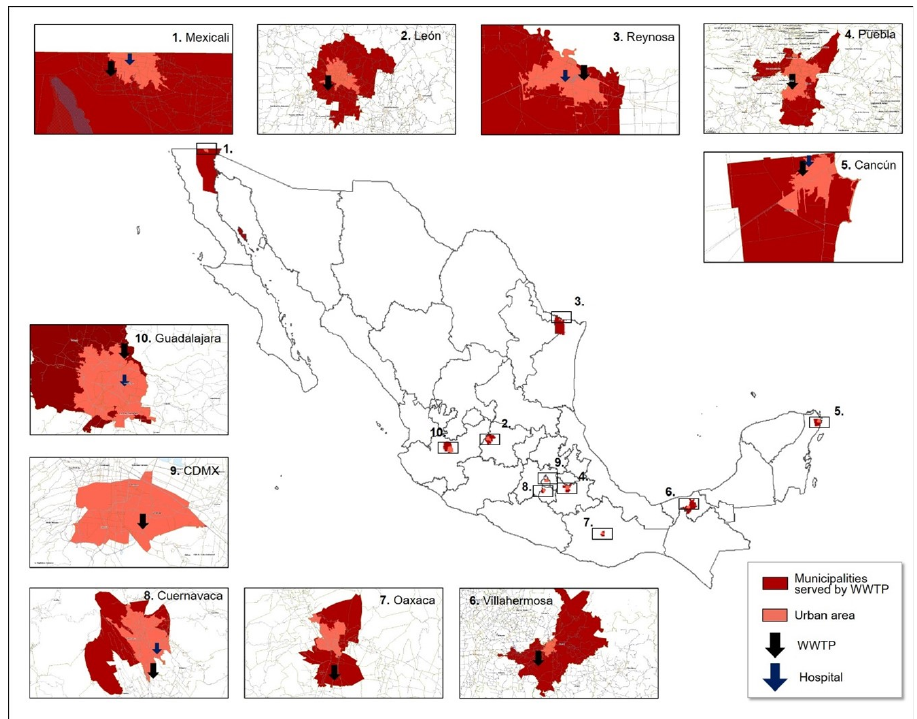
Figure 1. Map of sampled sites: WWTP and COVID-19 hospitals.